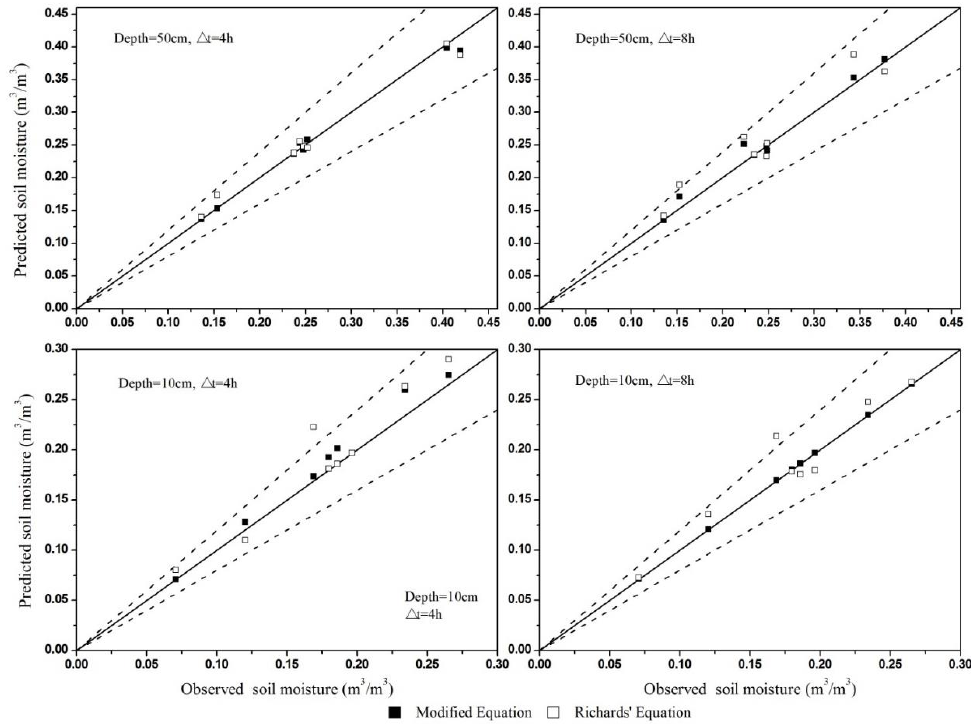
Figure 4. Comparison of simulated and observed soil moisture at various measurement points and soil depths. Water 2018 , 10 , x